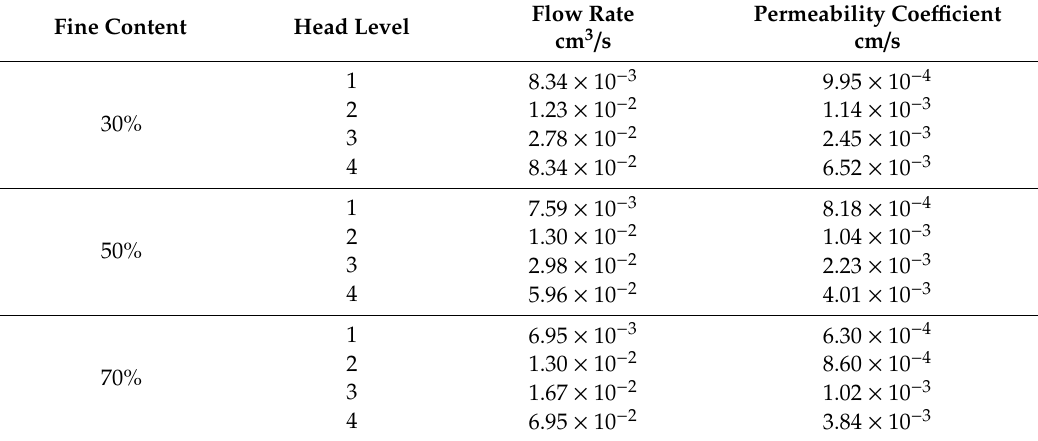
Table 3. Seepage velocity and permeability coe ffi cient during the